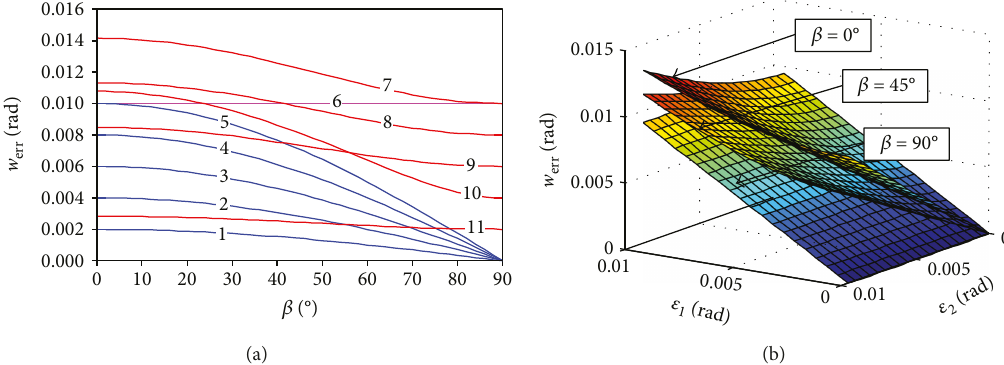
Figure 6: In fl uence of the tracking error of the EATD on the dish concentrator. 1: ε ε =0mrad, ε 1 8: ε =8mrad, ε 1